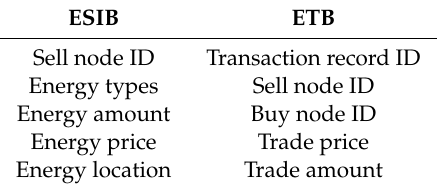
Figure 3. Data structures of energy supply index blockchain (ESIB). Table 2. Main difference between the data structure of energy trading blockchain (ETB) and ESIB.